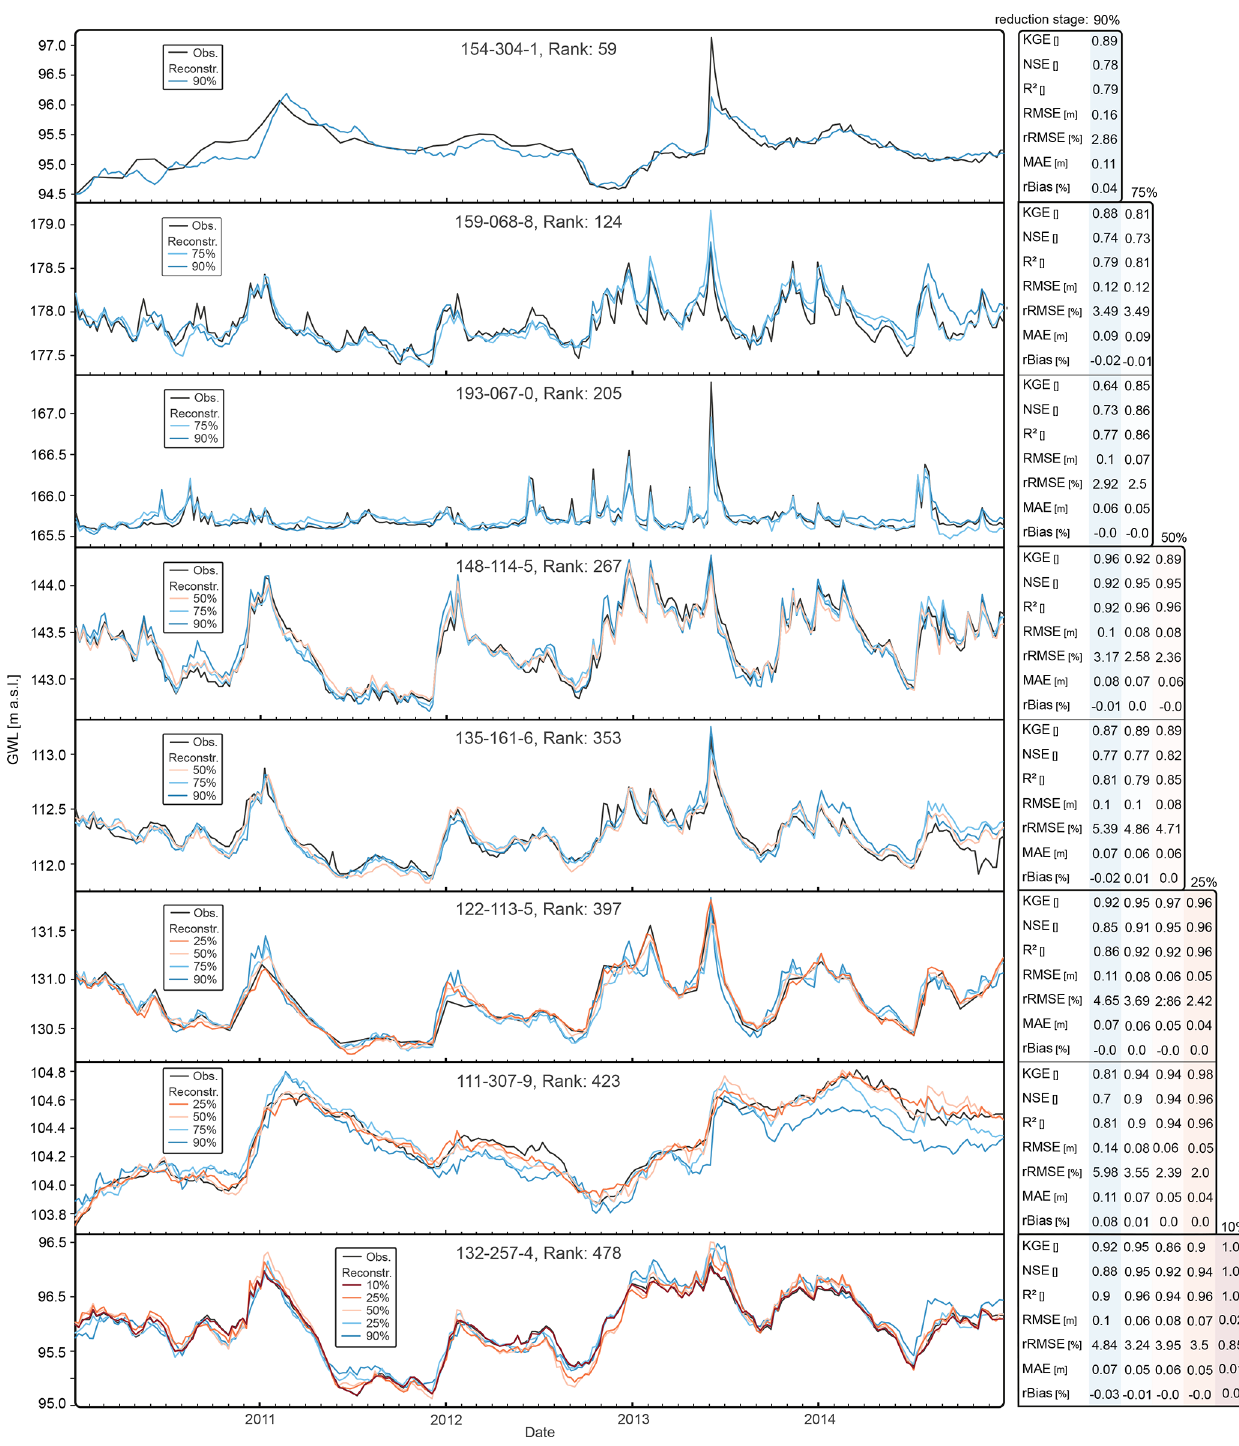
Figure 6. Hydrograph reconstruction at the five reduction stages 10%–90% shown for eight monitoring wells, along with the respective error